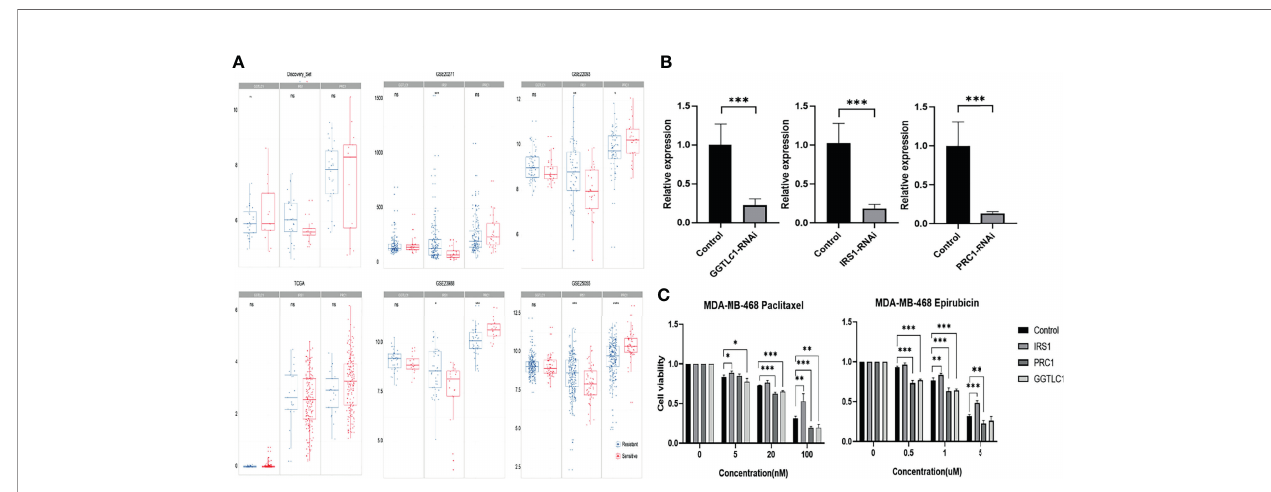
FIGURE 5 | (A) Comparisonof GGTLC1, PRC1, andIRS1 gene expressionsineach data set. (B) Knockdown ef fi ciency for GGTLC1, IRS1, andPRC1 were identi fi ed by qRT-PCR analysis. qRT-PCR,quantitative real-time polymerase chain reaction; *P<0.05, **P<0.01, ***P<0.001. (C) Evaluate the cellular sensitivity to chemotherapeutics of decreased expression ofIRS 1, PRC1, and TLC1 by the method of CCK-8. CCK-8: CellCounting Kit-8, *P<0.05, **P<0.01, ***P<0.001. ns, nosigni fi cance.